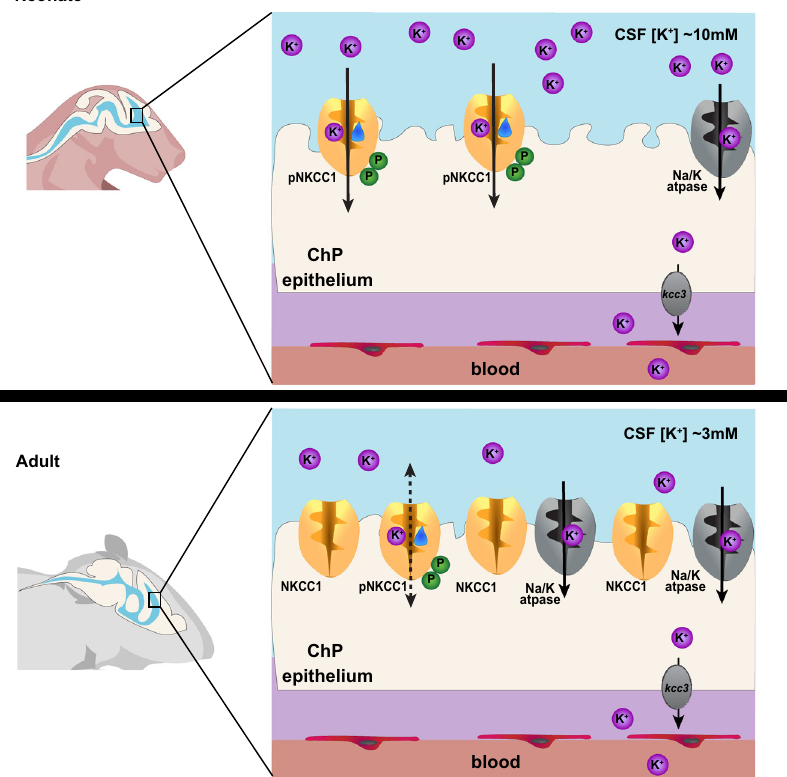
Fig. 7 Working model of ChP NKCC1 mediating K + -driven CSF out fl ow. The schematics depict ChP NKCC1-mediated K + and water clearance from CSF in neonatal mice, in comparison to the adult scenario. For simplicity and clarity, only K + is depicted among all ions and only NKCC1 and Na + /K + -ATPase are included. Neonatal (P0-7, above) ChP has higher pNKCC1 expression than adult ChP, albeit lower total NKCC1. Neonatal CSF [K + ] is 2 – 3 fold higher than adult. With similar [Na + ] and [Cl − ], this [K + ] difference is suf fi cient to alter the total Nernst potential of epithelial cells and bias NKCC1 transport of K + , together with water, out of CSF and into the ChP in